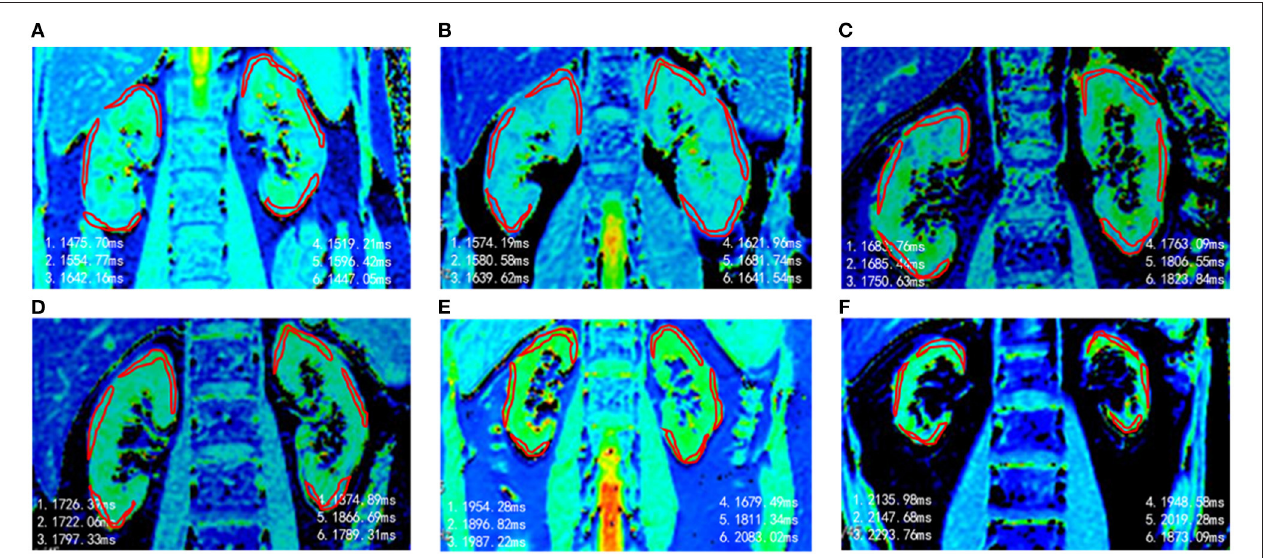
FIGURE 1 | Representative T1 maps of renal cortex in different groups. (A) HVs, T1 = 1,539ms. (B) CKD 1, T1 = 1,622ms. (C) CKD 2, T1 = 1,751 ms. (D) CKD 3, T1 = 1,796ms. (E) CKD4, T1 = 1,902ms. (F) CKD 5, T1 = 2.068ms.